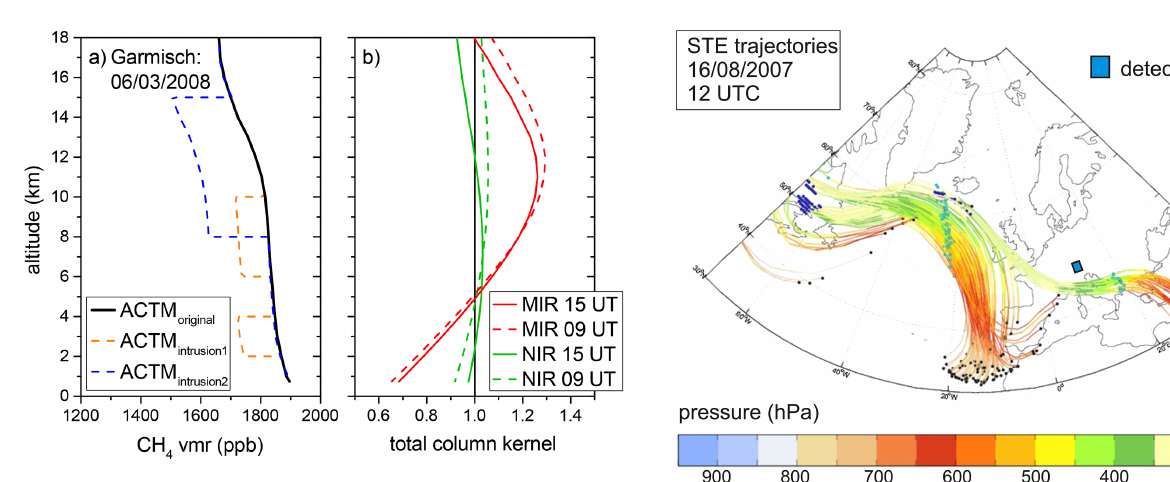
Figure 7. (a) ACTM profiles used for the a posteriori correc- tion of MIR and NIR retrievals of Garmisch spectra recorded on 6 March 2008: ACTM original is the original ACTM profile used in the correction. ACTM intrusion1 and ACTM intrusion2 are the original ACTM profiles which were modified due to a deep stratospheric intrusion event on this day. ACTM intrusion1 is used for the recorrec- tion of retrievals before 11:00UTC, ACTM intrusion2 is used for the recorrection of retrievals after 11:00UTC. (b) Averaging kernels for MIR and NIR retrievals of Garmisch spectra recorded on 6 March 2008.